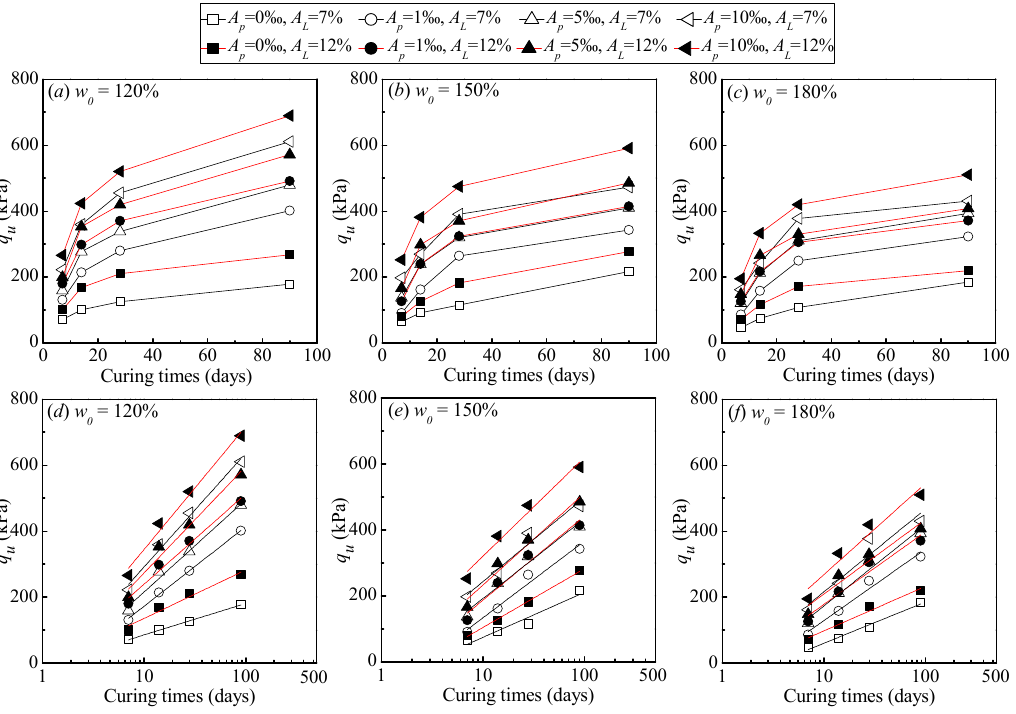
Figure 5. Strength development with curing times.